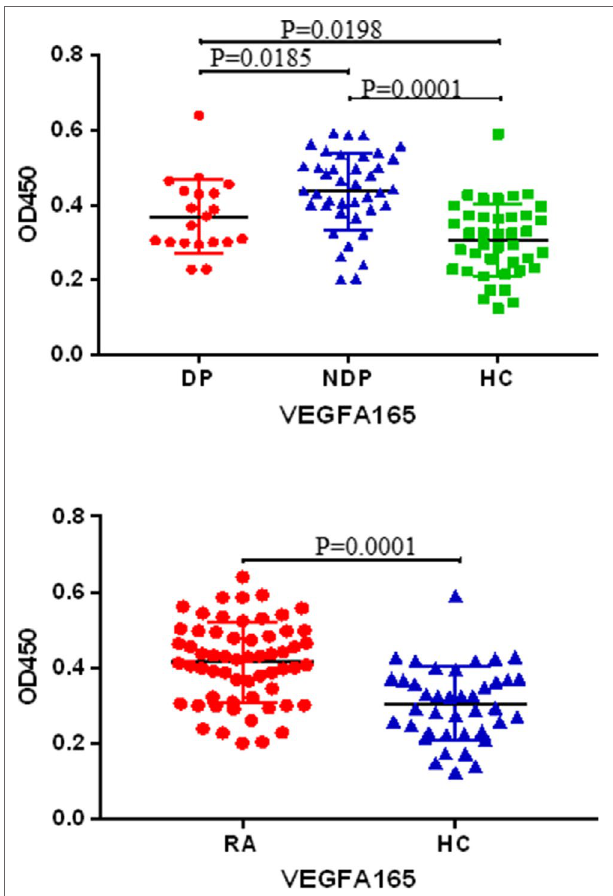
FIGURE 4 | The result of protein chip was verified by enlarging the sample by ELISA. Sera derived from DP (n = 20), NDP (n = 40) and HC (n = 40) were tested for VEGFA165 autoantibody using